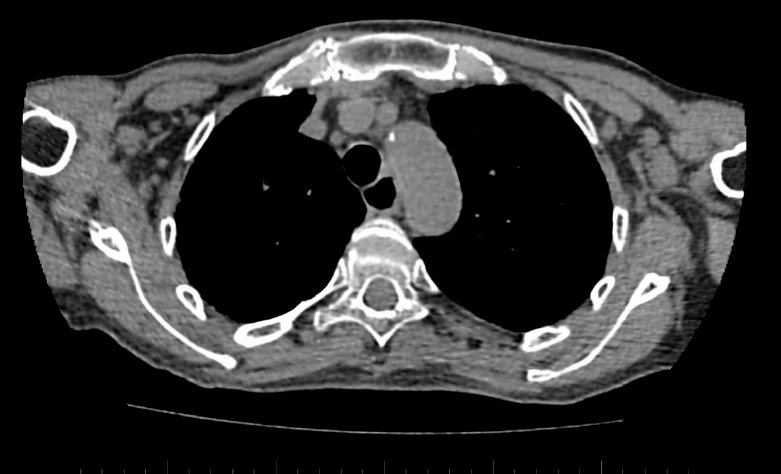
Figure 6. Computed tomography (CT) scan reveals dilated esophagus—RL diameter of approxi- mately 20 mm.